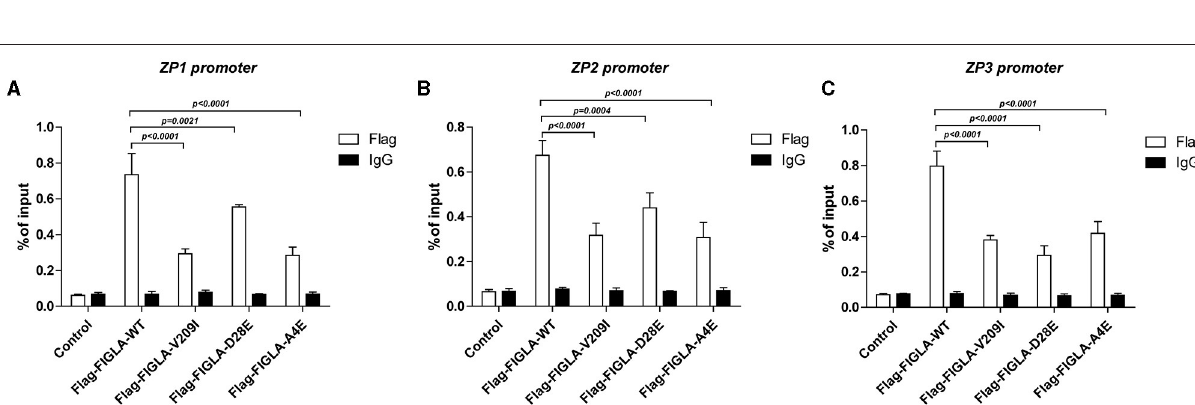
Frontiers in Medicine |